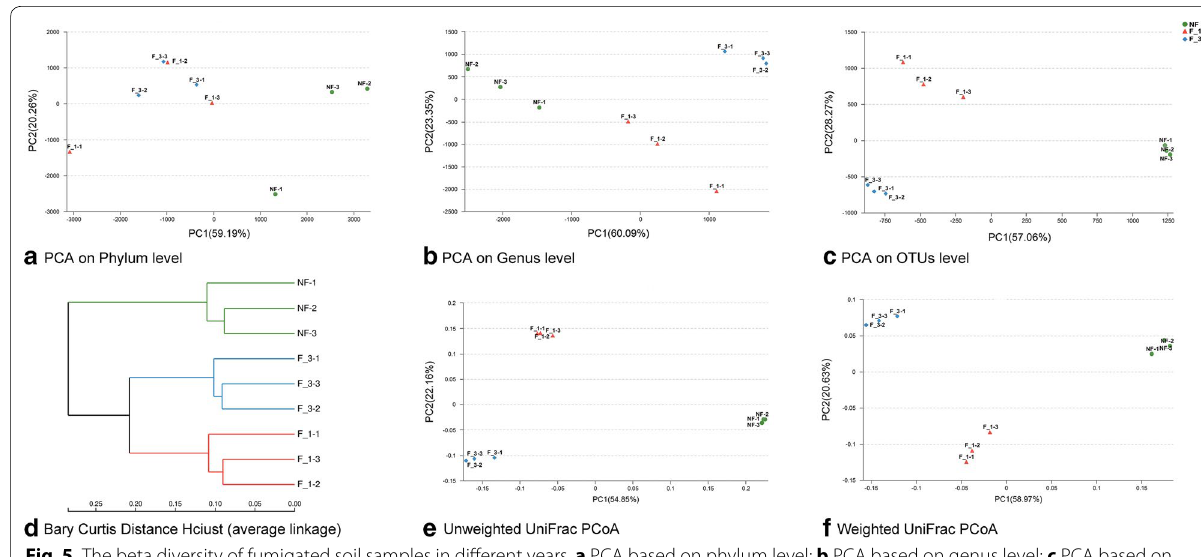
Fig. 5 The beta diversity of fumigated soil samples in different years. a PCA based on phylum level; b PCA based on genus level; c PCA based on total OTUs; d Cluster analysis based on bray–curtis. e PCoA analysis with unweighted UniFrac; f PCoA analysis with weighted UniFrac. NF non-fumi- gation, F_1 chloropicrin-fumigation for 1 year, F_3 continuous chloropicrin-fumigation for 3